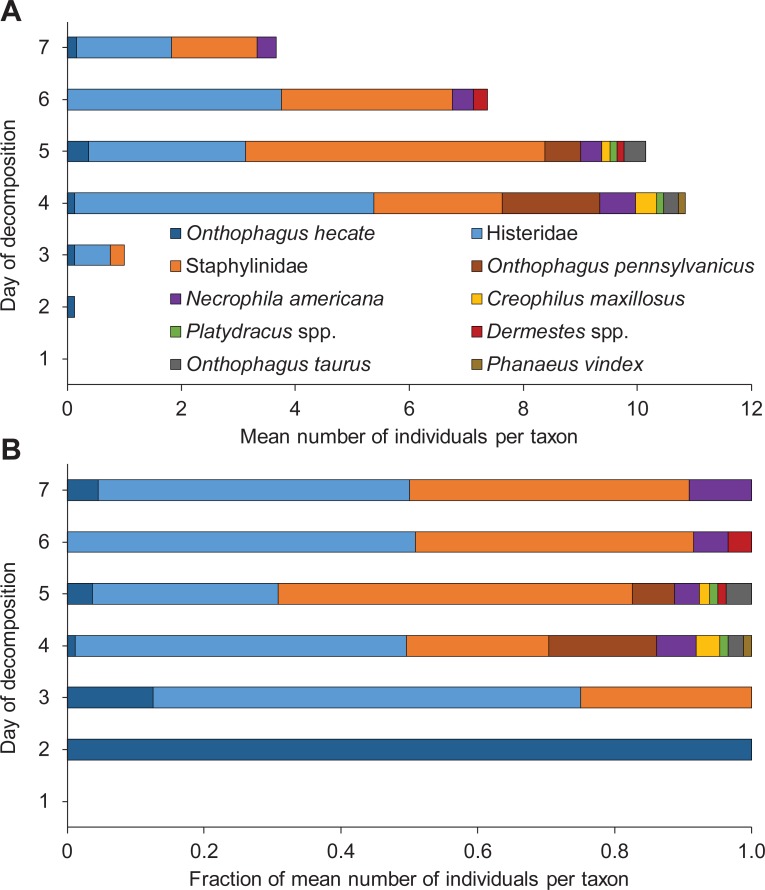
Mean number (A) and percentage representation (B) of coleopteran insects per taxon trapped or hand-collected daily from pigs during the 7-day decomposition process. n = 8 pigs.